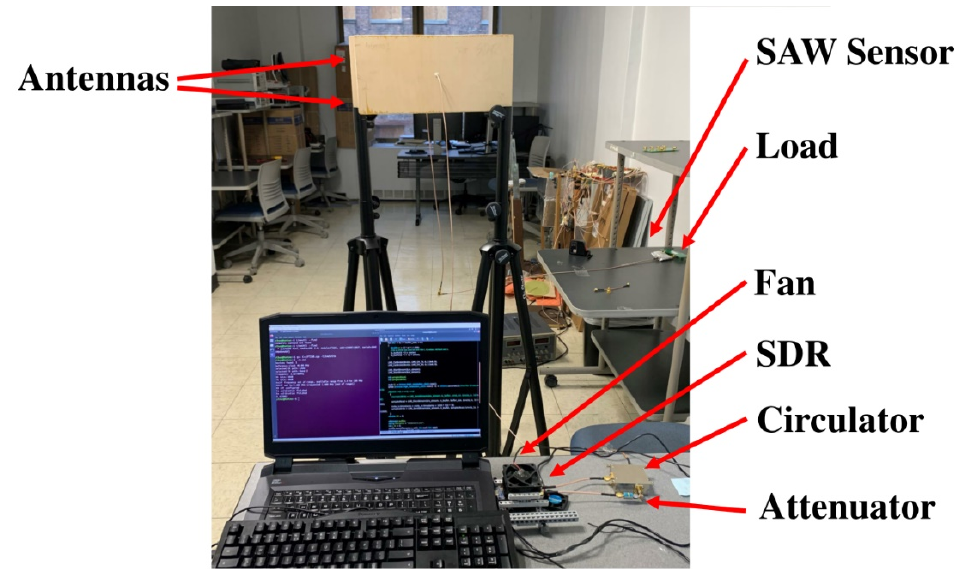
Figure 10. Experimental setup.